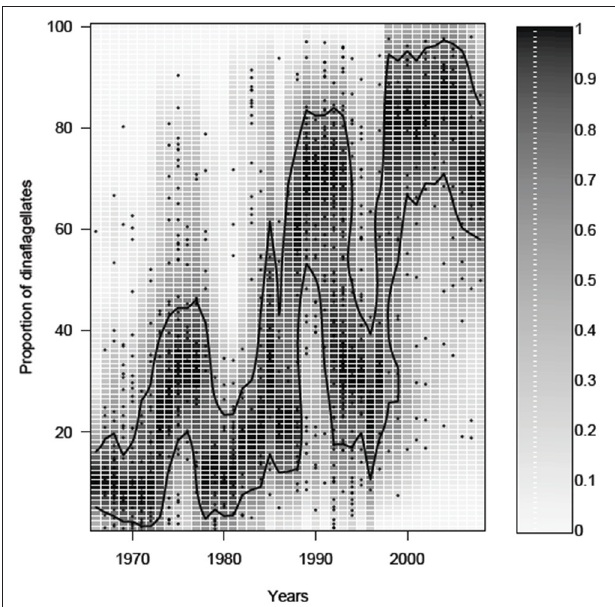
FIGURE 2 | Temporal change in the proportion of dinoflagellates from the sum of diatoms plus dinoflagellates in the spring bloom outside the city of Helsinki (Gulf of Finland). The symbols show the proportion of dinoflagellates in a particular sample. The gray scale shows the probability of having a particular dinoflagellate proportion, obtained by a kernel density estimate of a particular year. The contour line shows the 75% probability